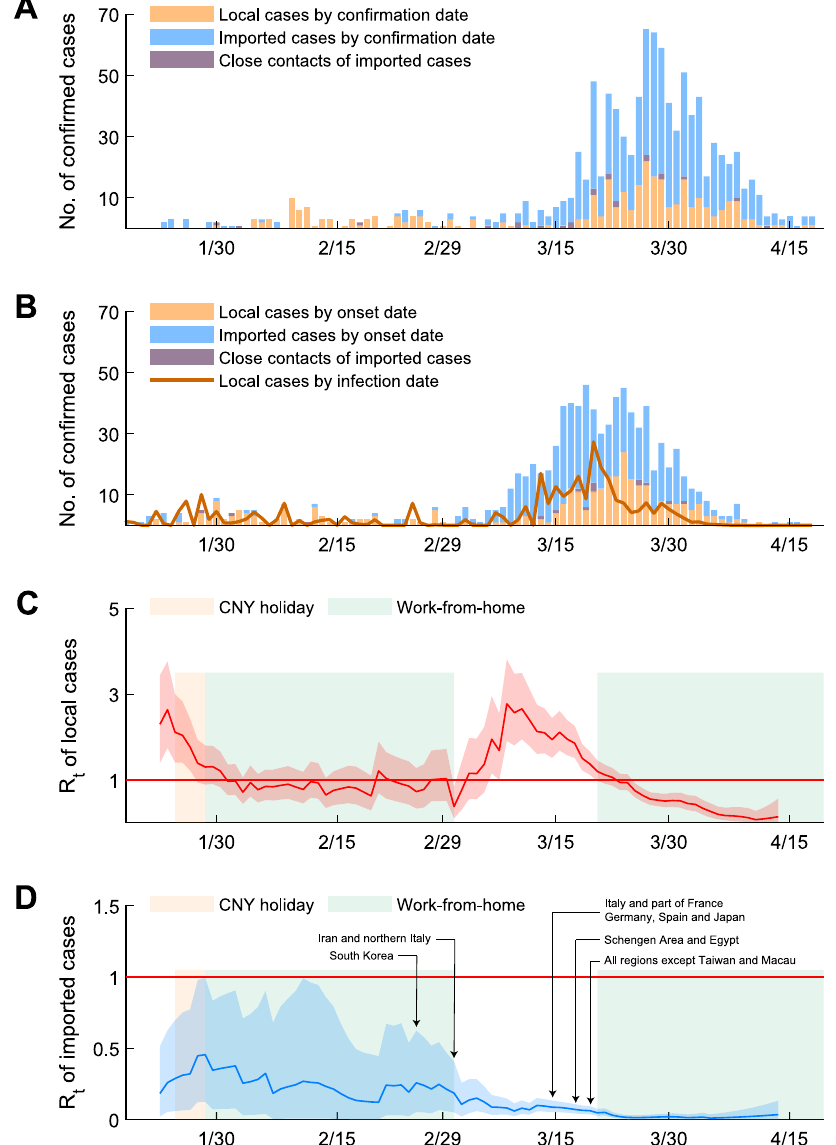
Fig. 1 Transmissibility of COVID-19 in Hong Kong. A , B The epidemic curves by dates of con fi rmation and symptom onset strati fi ed by imported cases, close contacts of imported cases, and local cases. The epidemic curve of local cases by dates of infection was estimated using deconvolution. C , D R t estimates of local and imported cases by dates of infections on sliding weekly windows using methods from Thompson et al. Local cases only include CHP categories of local case, possibly local case, epidemiologically linked with local case and epidemiologically linked with the possible local case. The light shades showed the Chinese New Year holidays and the time period when “ work-from-home ” arrangements were implemented for civil servants. Fourteen- day quarantine was mandated for travelers from South Korea since 25 February; Iran and northern Italy since 1 March; Italy and affected area in France, Germany, Spain, and Japan since 14 March; Schengen area and Egypt since 17 March; all regions and countries except Taiwan and Macau since 19 March; and all regions and countries since 25 March. Red lines and shades indicated the posterior mean and 95% credible intervals of local R t estimates. Blue lines and shades indicated the posterior mean and 95% credible intervals of R t estimates for imported